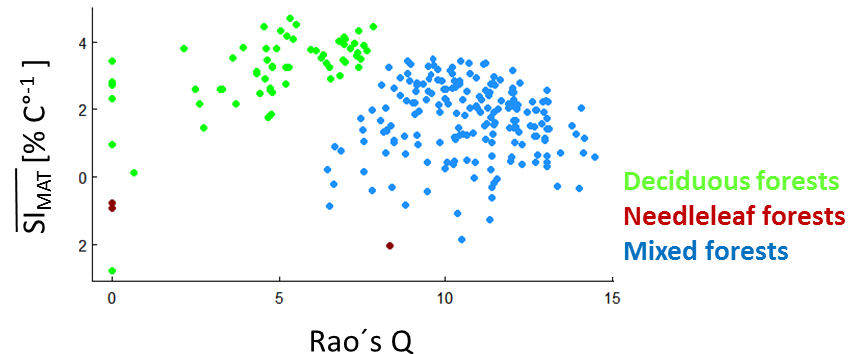
Figure B7. Rao’s Q (with equal abundances) against SI MAT values of all possible species mixtures (from the forest factory). The SI MAT values are the average over all SI MAT values for all light–height combinations and with values larger than − 7.5% ◦ C − 1 . For mixtures, we assumed equal abundances and calculated the mean over the SI MAT values of all species within the mixture. Green dots indicate forests that consist only of deciduous trees; red dots indicate forests that consist only of needleleaf trees; blue dots indicate forests that contain both tree